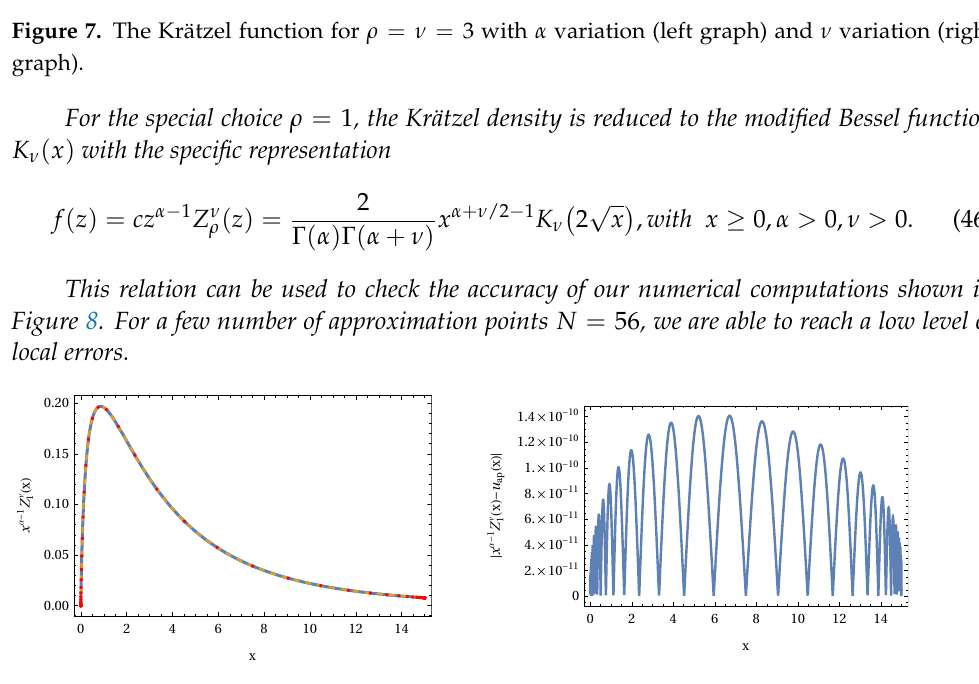
Figure 8. The Krätzel function for ρ = 1, ν = 1/3 and α = 2 (left graph). Right panel local error between the approximation and the Bessel representation. Number of Sinc points N =